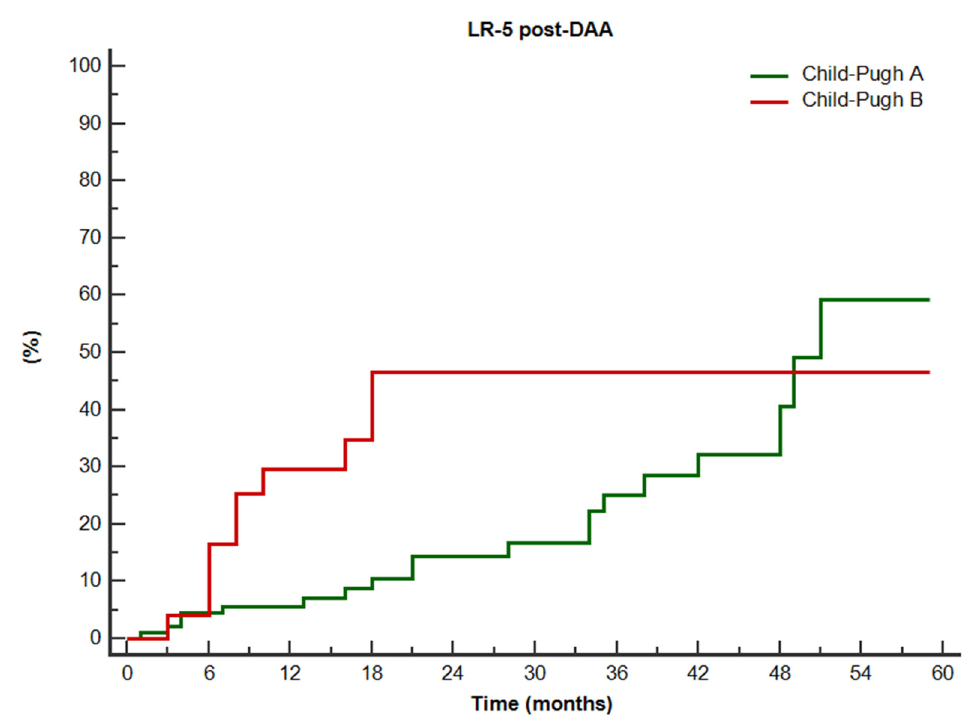
Figure 4. Cumulative Kaplan-Meier curves for LR-5 occurrence after direct acting antivirals, according to the Child-Pugh class. Log-rank p for comparison of curves: 0.048.